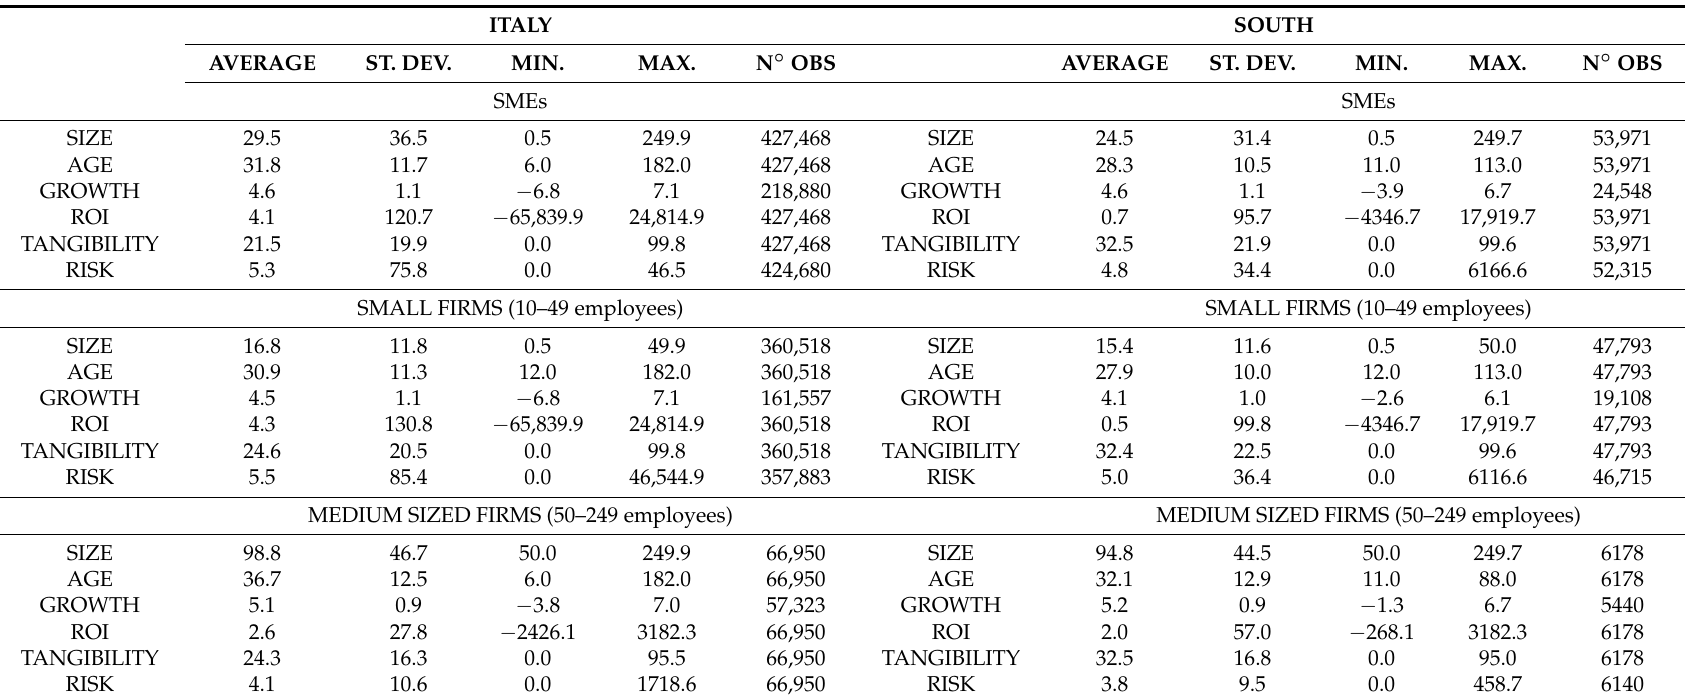
Table 4. Main statistics for firm-level